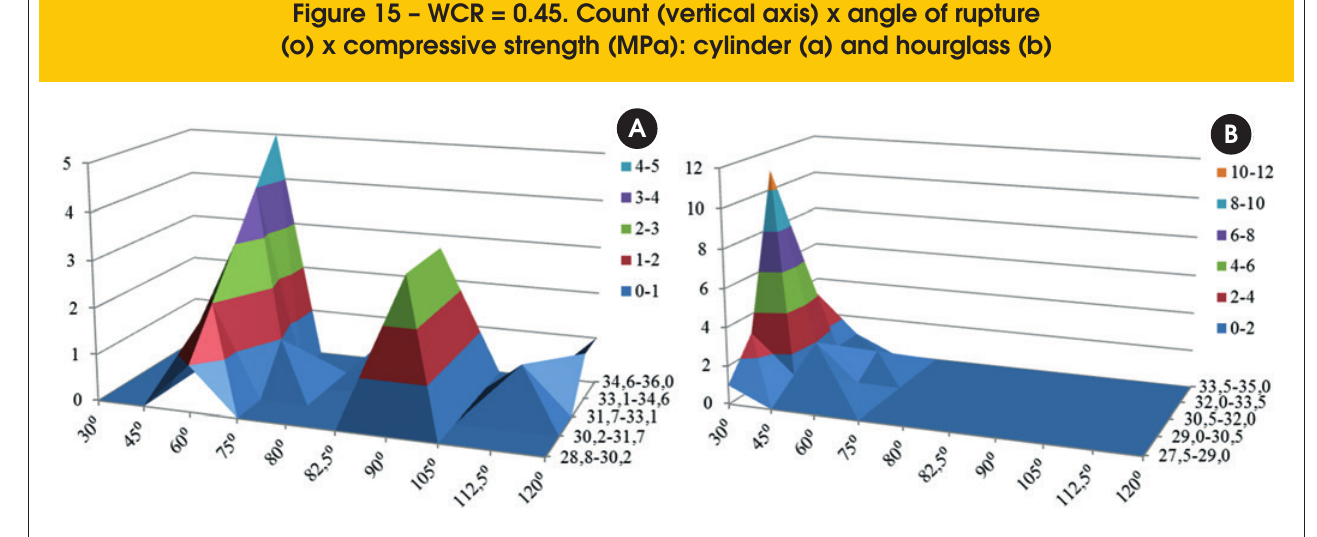
Figure 15 – WCR = 0.45. Count (vertical axis) x angle of rupture (o) x compressive strength (MPa): cylinder (a) and hourglass (b)